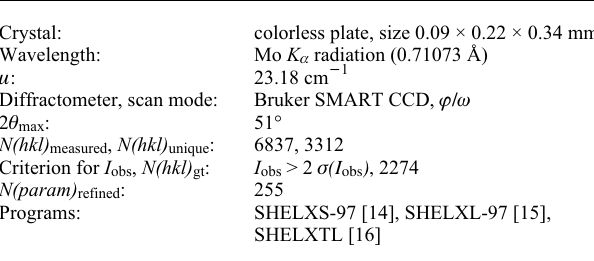
Table 2. Atomic coordinates and displacement parameters (in Å 2 ) .